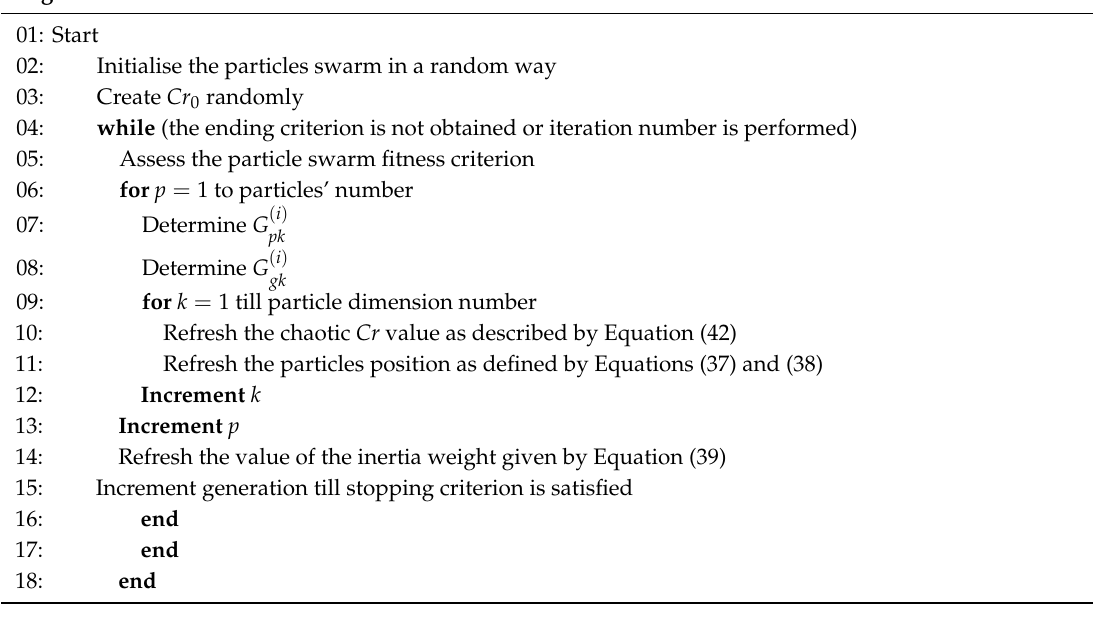
Algorithm 2 Pseudo-code of the